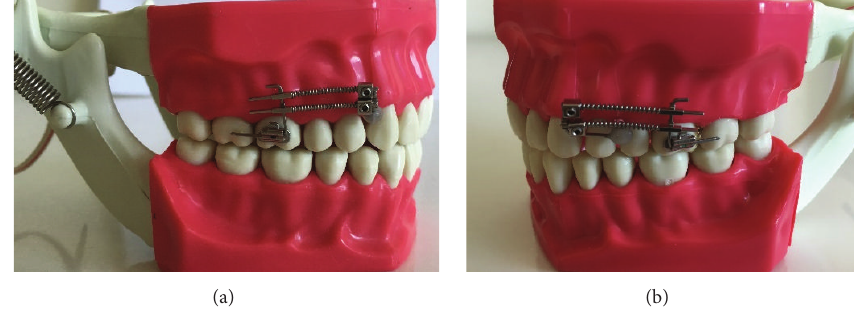
Figure 2: Cise distalizer on model without activation.